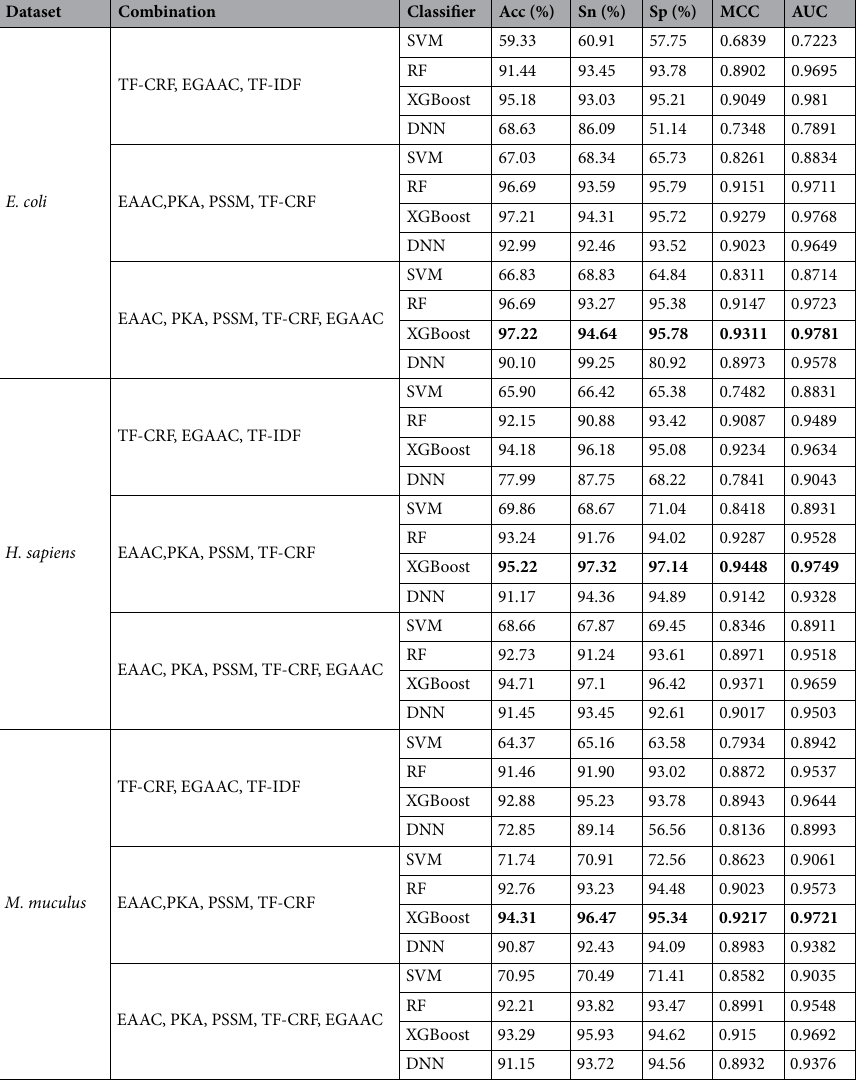
Table 2. The performance of classifiers with various feature combinations. Significant values are in